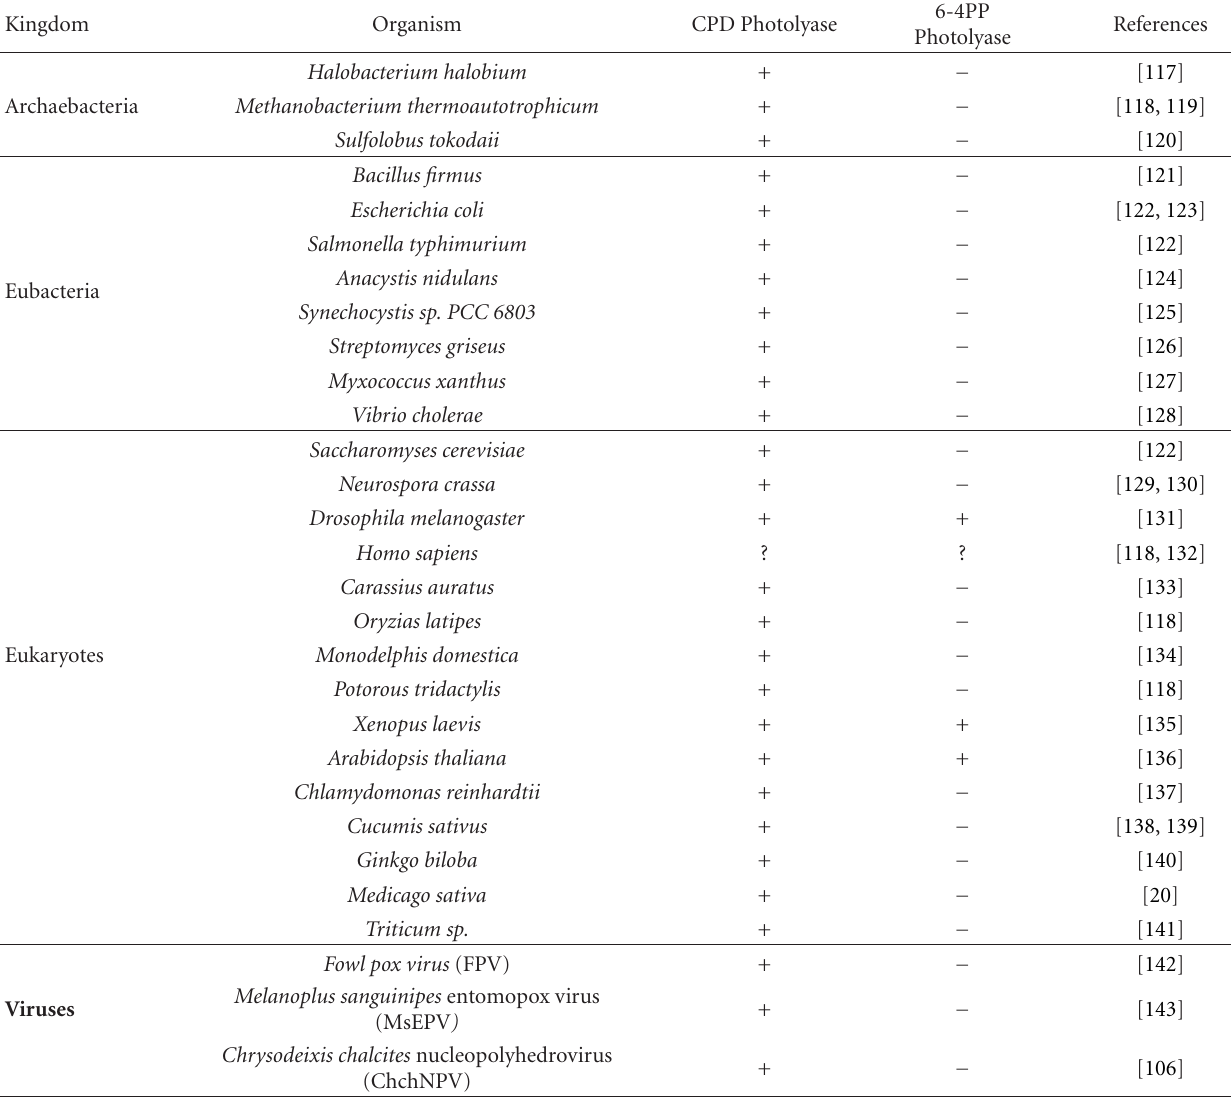
Table 2: Photolyase enzymes in four di ff erent